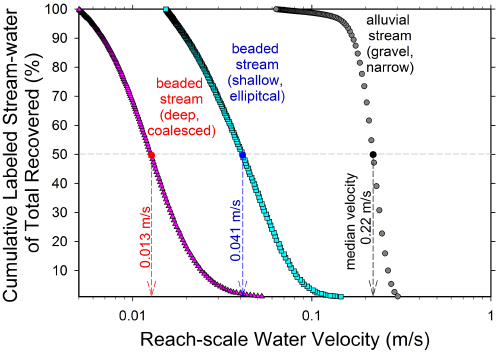
Figure 14. Examples of reach-scale water velocity distributions (reach length/travel time) measured using hydrologic tracer tests (rhodamine WT pulse additions) shown as cumulative tracer recov- ered downstream. Results from two beaded streams, Crea Creek (blue squares) and Blackfish Creek (red triangles) are compared to an alluvial stream (black circles) in a mountain meadow (Arp unpublished data, stream described in Arp et al., 2007); all three streams had similar discharges ranging from 85 to 140Ls − 1 during tracer tests and slopes ranging from 0.1 to 0.2%, but with otherwise differing morphologies (experimental data and inverse modeling re- sults shown in Table